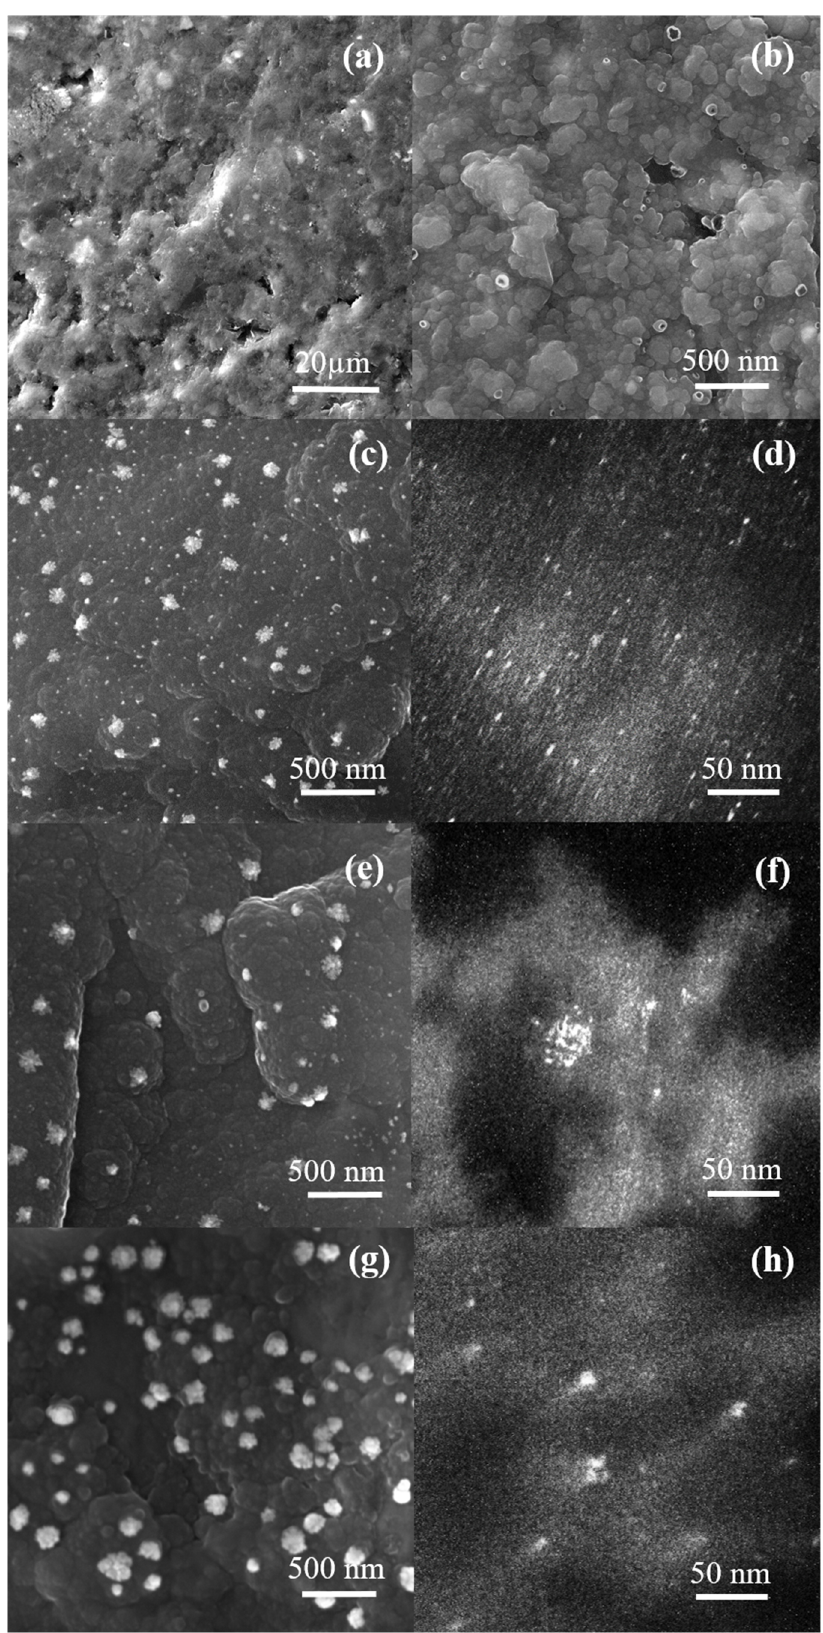
Figure 1. Representative SEM and dark-field TEM images, respectively, of bare graphite ( a ), modified graphite electrodes with PPy ( b ), PPy/AuNPs 15 s ( c , d ), PPy/AuNPs 30 s ( e , f ) and PPy/AuNPs 45 s ( g , h ).